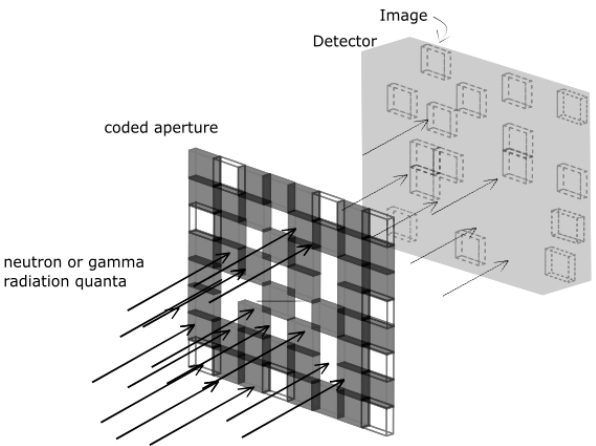
Figure 5. A schematic of coded aperture imaging system, with a coded aperture mask that is made with a pattern of opaque and open cells of highly attenuating materials followed by a radiation sensitive detector. Incident radiation field is attenuated in the coded aperture mask, with only a fraction of incident radiation is transmitted and detected on the system (based on reference [37]).